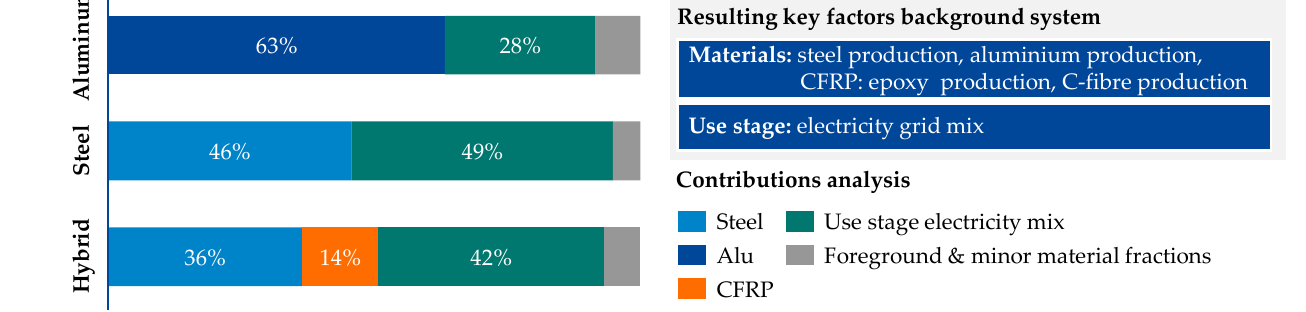
Figure 5. Key factor analysis for the background system based on a cradle-to-grave perspective showing the relative contribution of each key factor. Identified key factors for the background system are the material production and the electricity grid mix for the use stage.